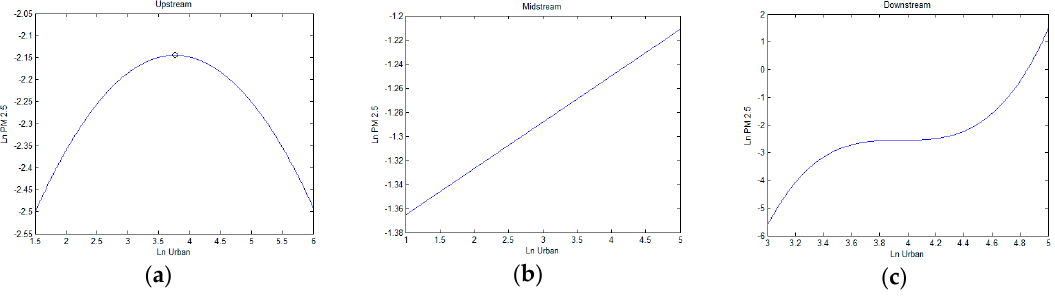
Figure 4. Diagrams relationships between population urbanization and PM 2.5 in three areas: ( a ) upstream, ( b ) midstream, and ( c ) downstream.